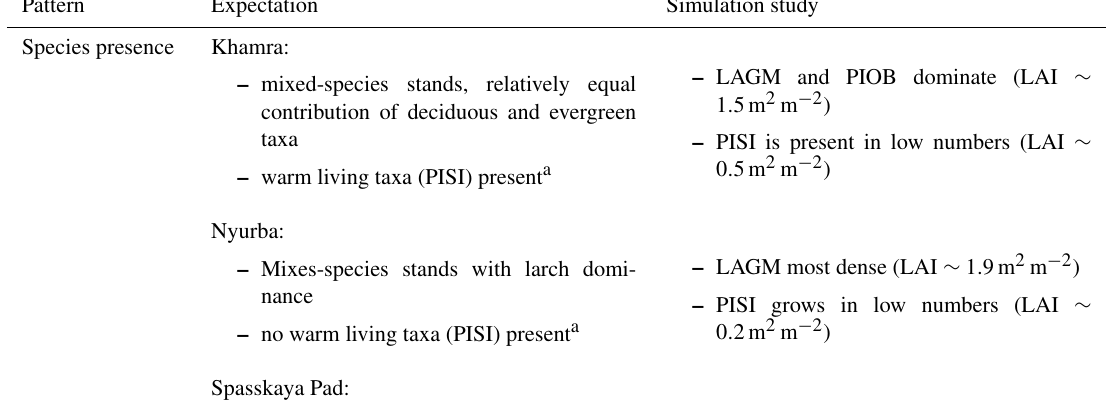
Table 4. Qualitative comparison of simulation results to expectations based on observations.